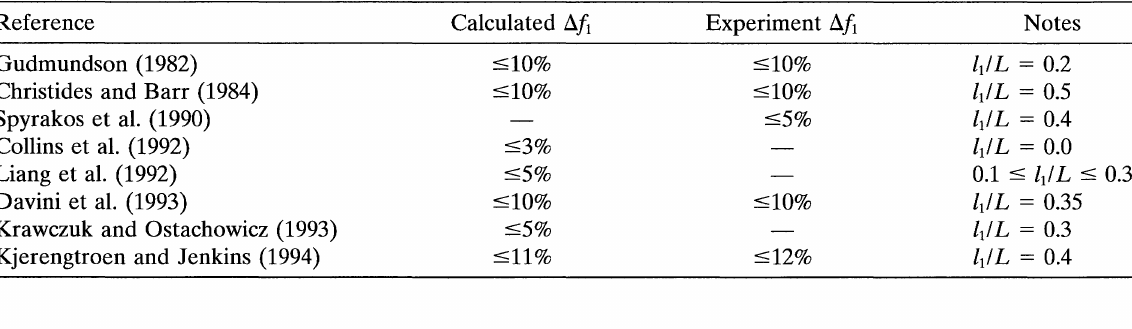
Table 1. Comparison of Reported Maximum Changes in Fundamental Frequency for Beams with Edge Damage (alh = 0.5), Calculated and Experimental